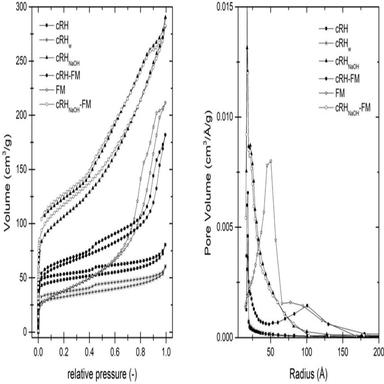
left panel: Ar adsorption/desorption isotherms of FM, raw cRH, cRHw, cRHNaOH, cRH-FM, and cRHNaOH-FM at 87 K. right panel: Pore-size distributions (PSD) evaluated by BJH model.